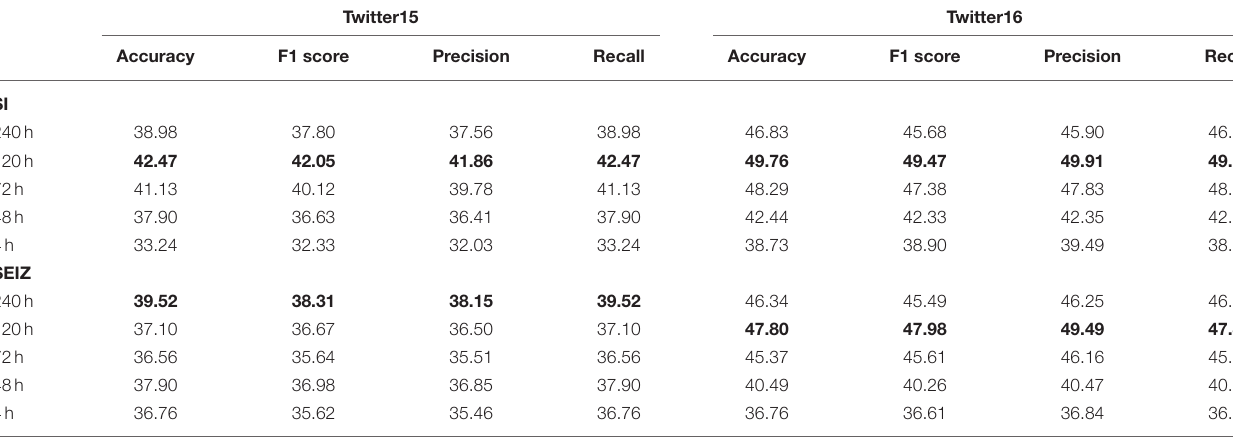
The best performing experimental setups are provided in bold.